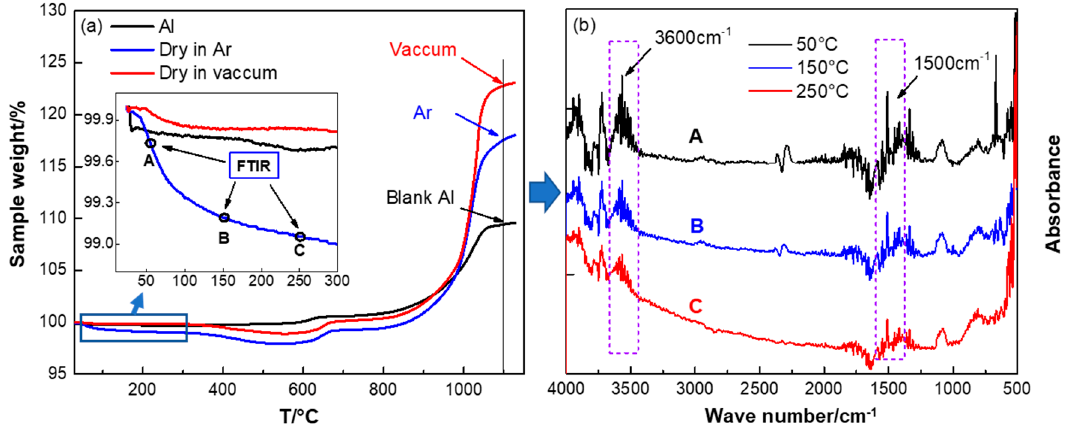
Figure 6. Thermogravimetric analysis (TGA) curves of PTFE coated Al ( a ) and the FTIR spectra of the components in the early stage mass loss ( b ). The testing conditions were, air atmosphere, 10 K/min. The preparation conditions of Al/PTFE were T h = 335 °C, t h = 4 h.